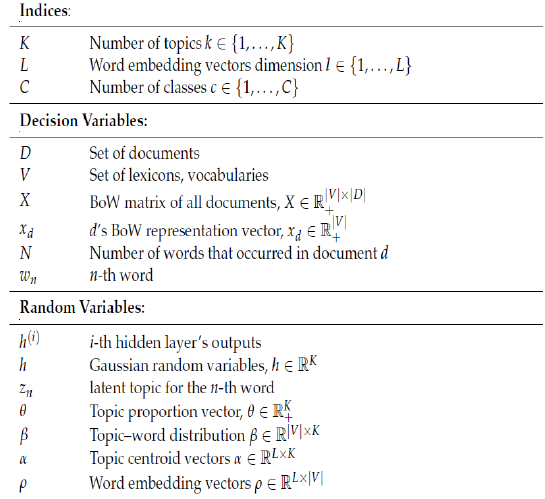
Figure 2 depicts the generalized architecture of the neural topic models based on variational autoencoders (VAE). The encoder is the part of the network that generates θ by mapping the bag-of-words (BoW) input to a latent document-topic vector, and the decoder is the part of the network that takes θ and gives p(x) by mapping the vector of document-topic to a separate